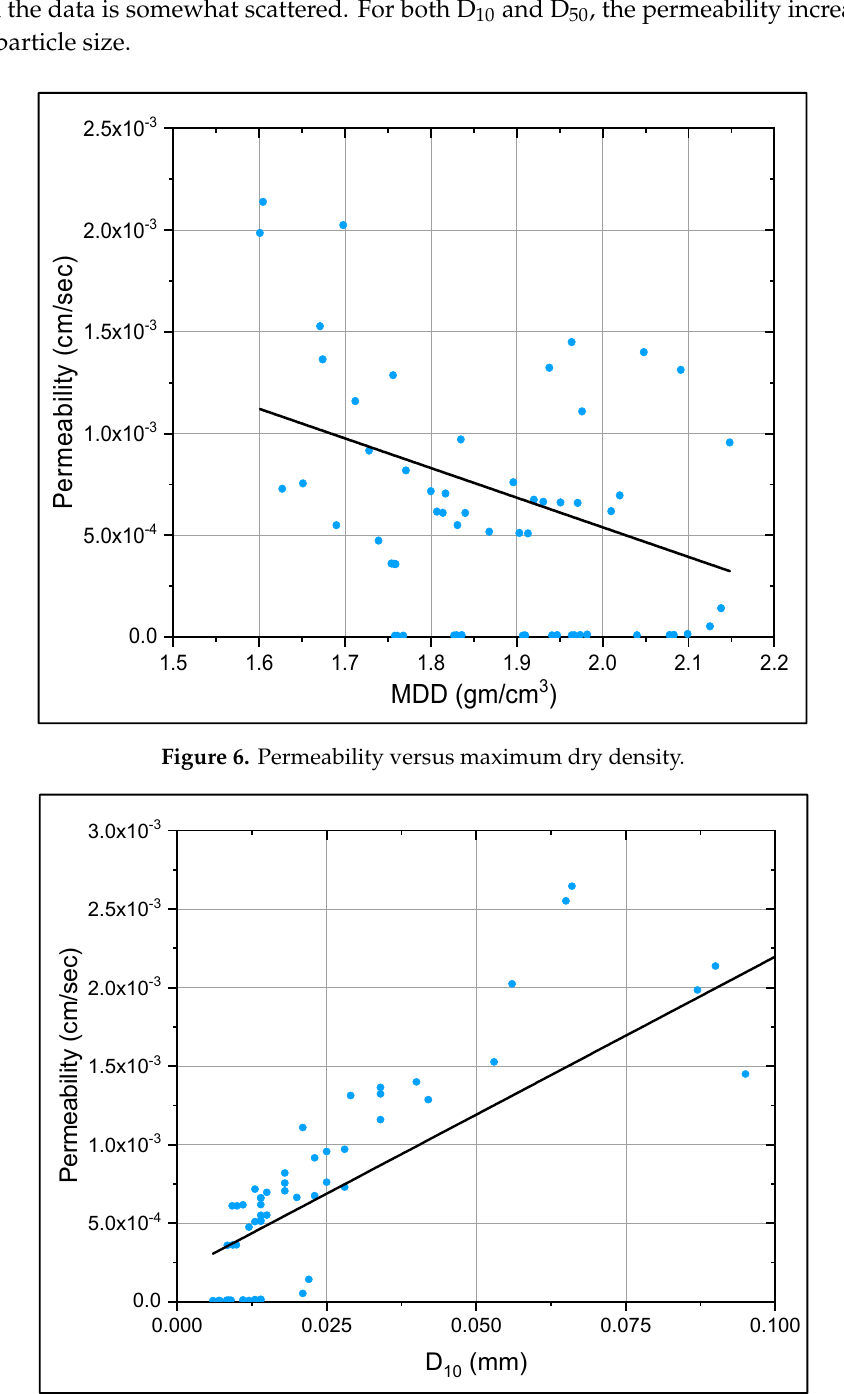
Figure 7. Permeability versus D 10.